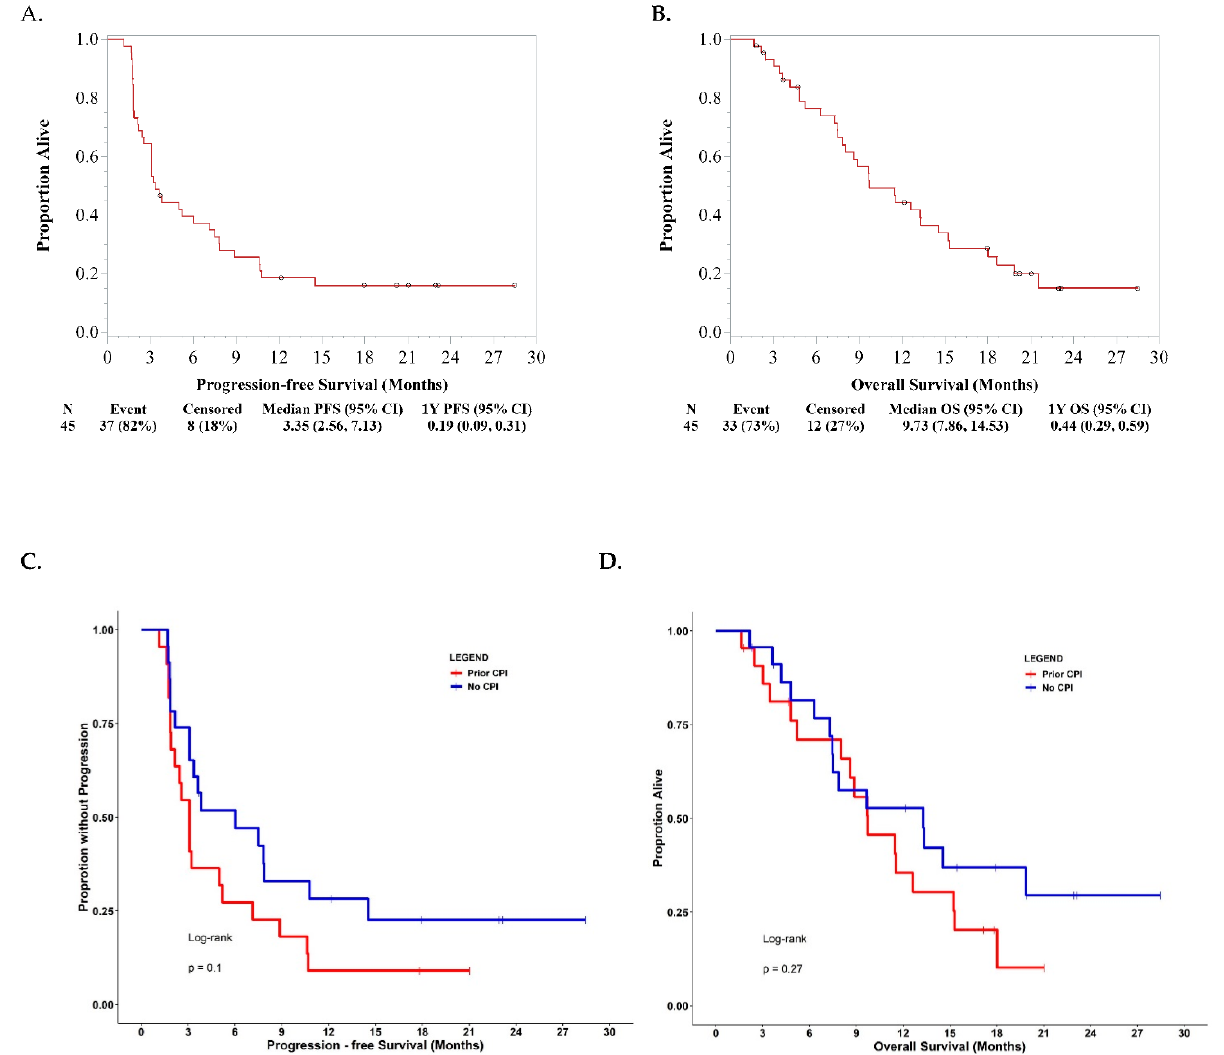
Figure 2. ( A ) Progression-free survival (PFS) given the combination of cetuximab and nivolumab. ( B ) Overall survival (OS) given the combination of cetuximab and nivolumab. ( C ) PFS based on exposure history to anti-PD-1 checkpoint inhibitors (CPI). ( D ) OS based on exposure history to anti-PD-1 CPI.